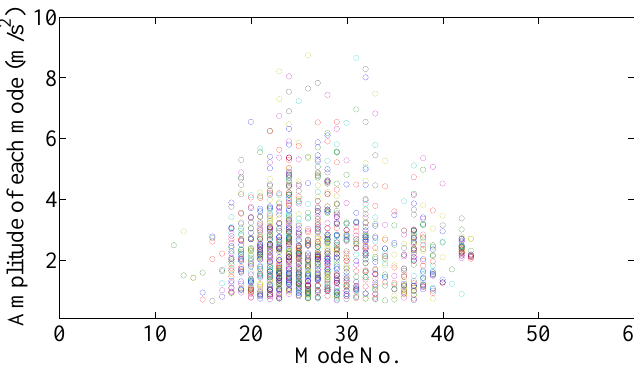
Figure 6. Vibration amplitude versus vibration modes of CAC20 cable.